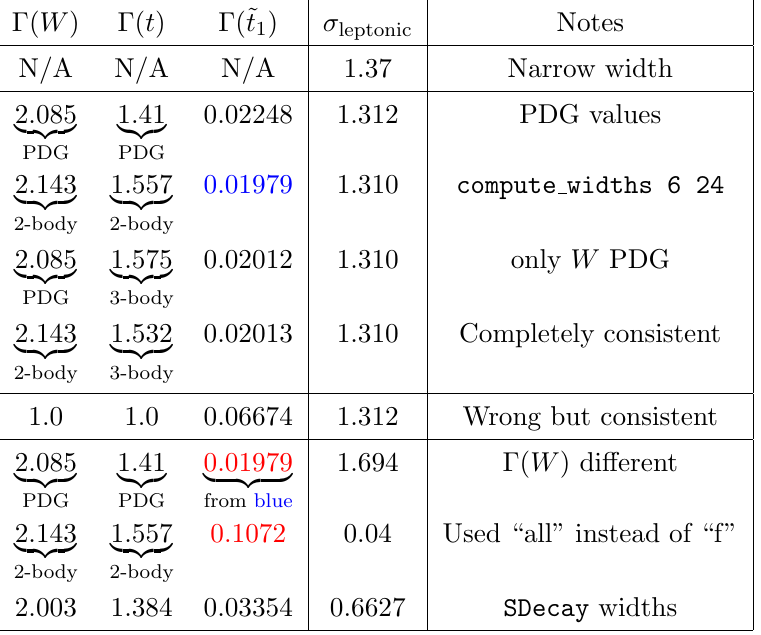
Table 3 . Cross section in pb for di(cid:11)erent widths in GeV of t , W , and ~ t